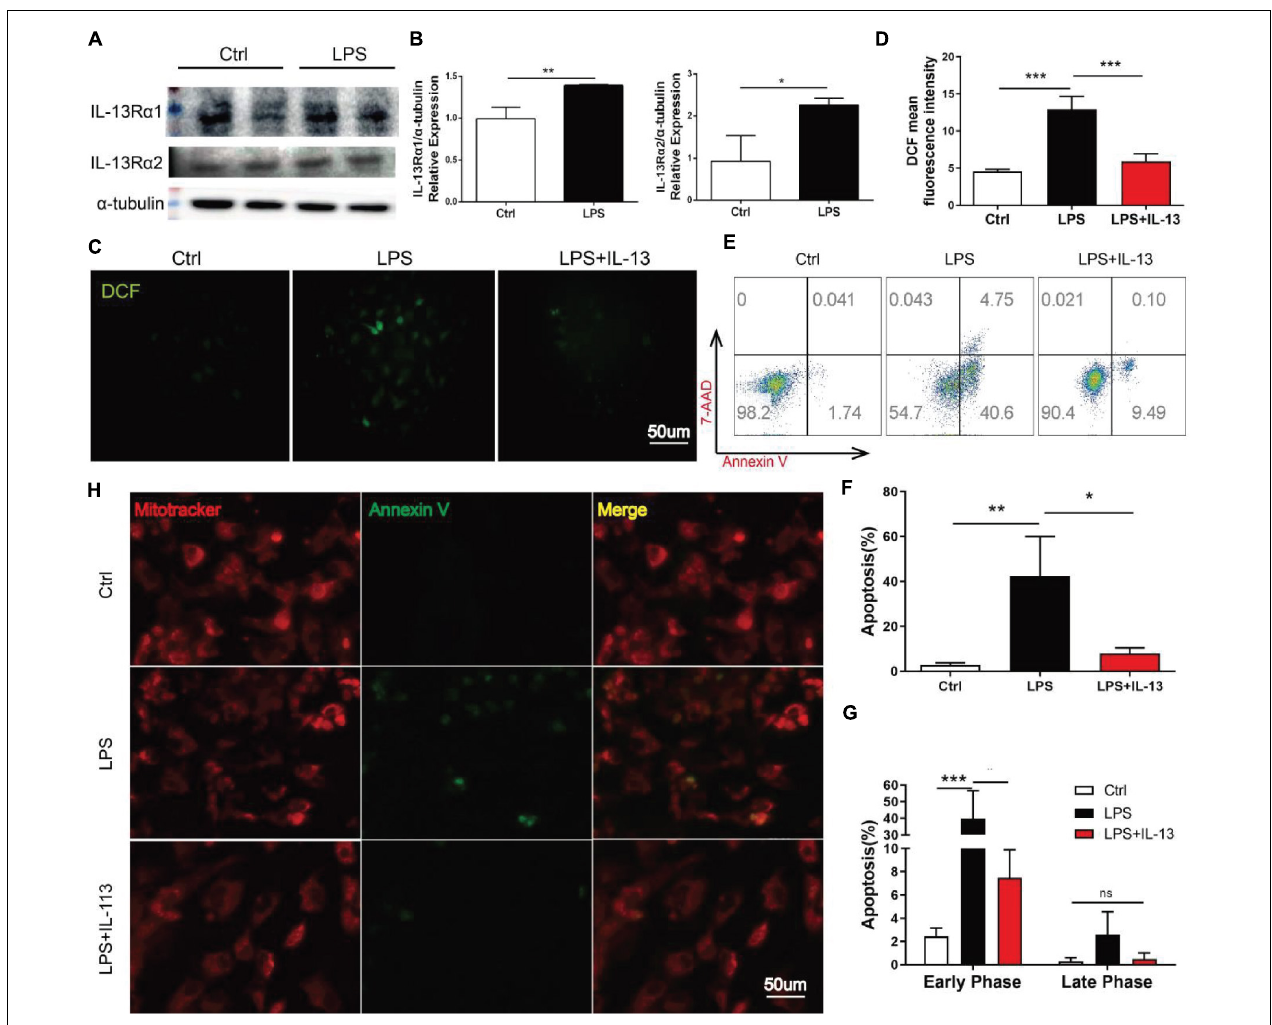
FIGURE 3 | IL-13 alleviated LPS-induced cardiomyocyte apoptosis. (A) Determination of IL-13R α 1 and IL-13R α 2 relative expressions in the primary cardiomyocytes by Western blot. (B) Quantification of (A) . (C) DCF fluorescent images, Scale bar = 50 µ m. (D) DCF mean fluorescent intensity. (E) Flow cytometry analysis of apoptosis. (F,G) Quantification of apoptosis. (H) Cardiomyocytes stained with mitoitrcacker (red) and Annexin V(green), Scale bar = 50 µ m. Data were expressed as the mean ± SD ( n = 3). * p < 0.05, ** p < 0.01, *** p <